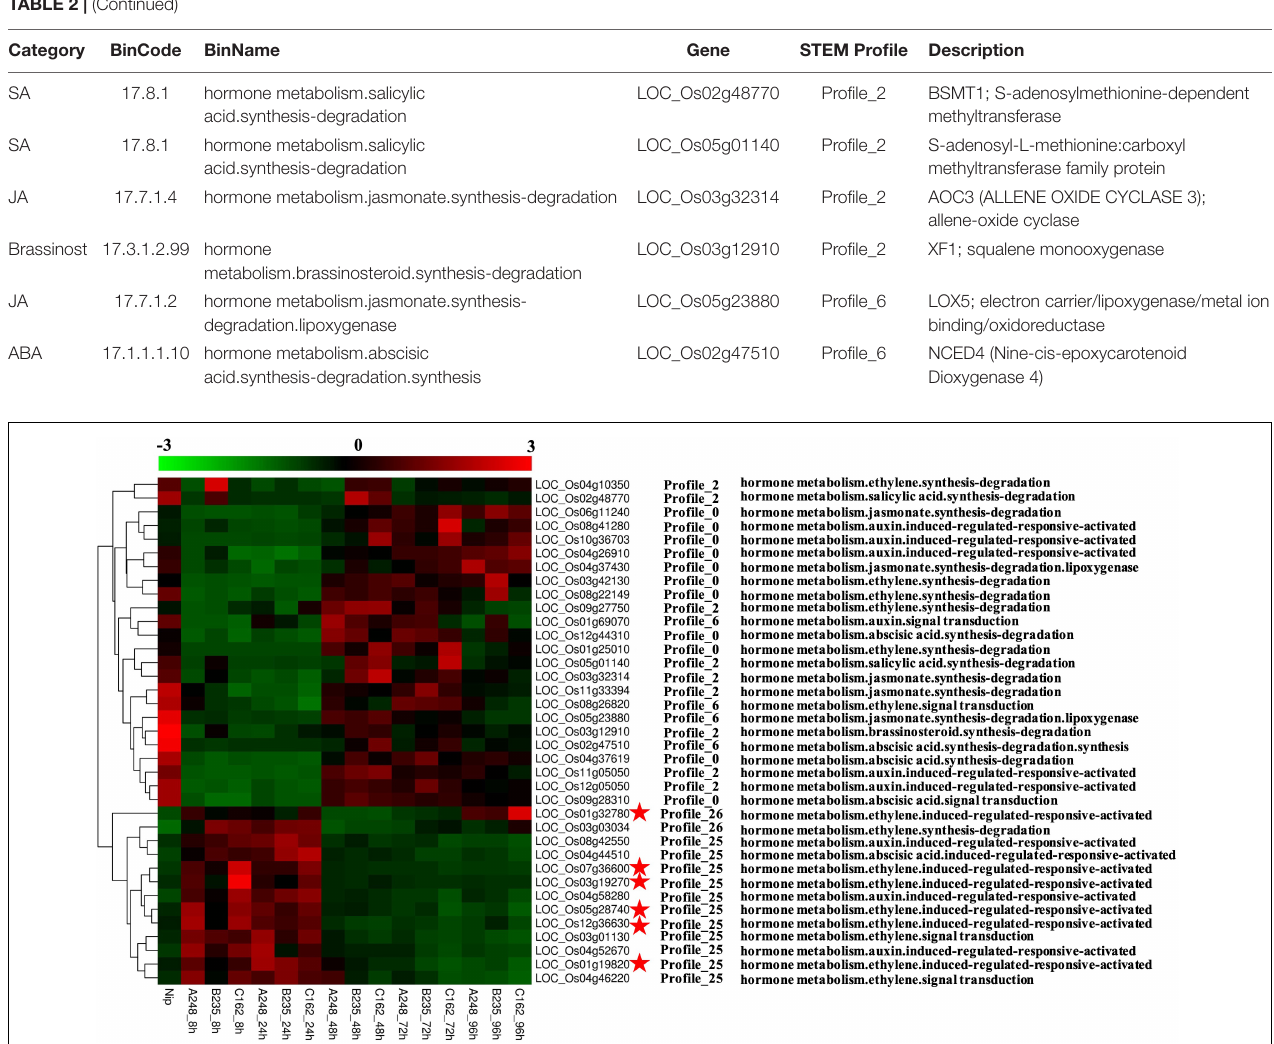
FIGURE 4 | Overview of O. sativa CDEGs assigned to hormone metabolism or hormone signaling based on the annotation of MapMan functional categories. Heat maps display expression patterns of these O. sativa CDEGs. The middle part of the figure shows these O. sativa CDEGs belong to Profile 25, 26, 0, 2, and 6 according to co-expression clustering. The right side of the figure displays MapMan annotation of these O. sativa CDEGs. Among these O. sativa CDEGs, encoding genes of universal stress proteins (USPs), induced by ethylene according to MapMan annotation, were marked by red asterisks.